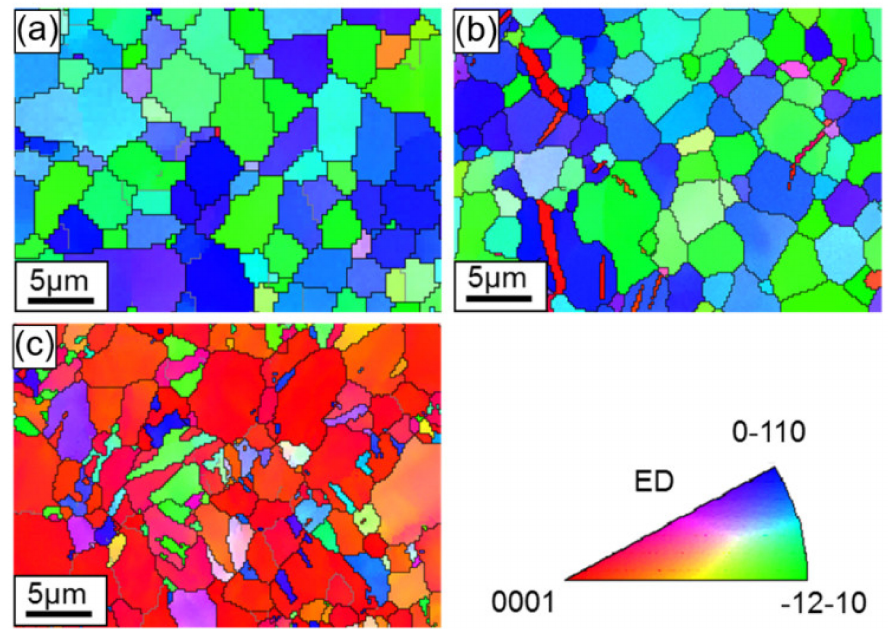
Figure 8. EBSD orientation maps, exhibiting microstructure in the ZK60 sleeve along the extrusion direction of the ZK60 / WE43 composite rod, to di ff erent true strain levels: ( a ) initial undeformed state (0), ( b ) compressive yield point (1.1%) and ( c ) compressive “ultimate” point (9.4%). The compressive direction, i.e., ED, is perpendicular to the maps. The color in the maps represents the local crystal lattice frame with respect to the ED / compressive direction according to the color